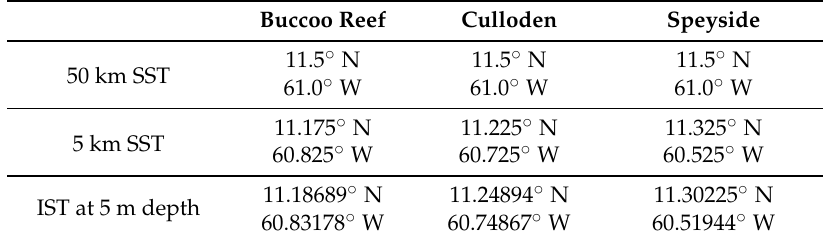
Table 1. Locations of sea surface temperature (SST) (satellite pixel center) and in situ temperature IST measurements for Tobago